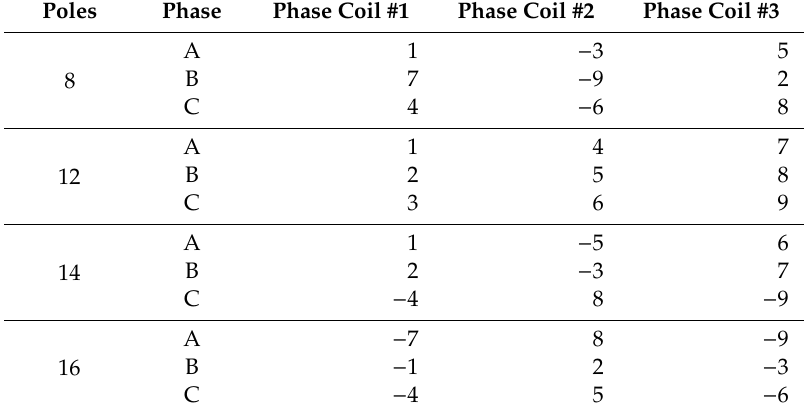
Table 3. Phase windings connections for di ff erent pole numbers (symmetric half of 18 coils total). Each consecutive coil was numbered and assigned to appropriate phase (row); minus sign designates inverted connection.